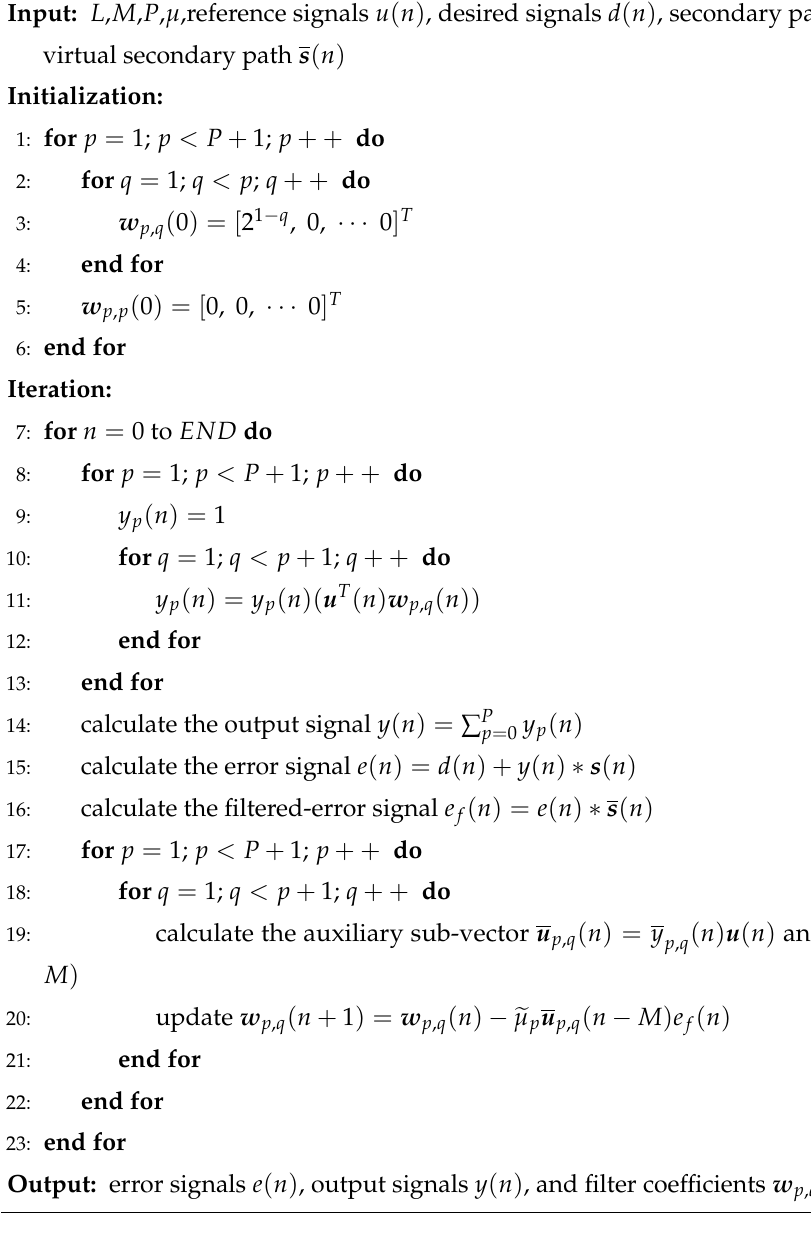
Algorithm 1 Pseudo code of the proposed DVMFELMS